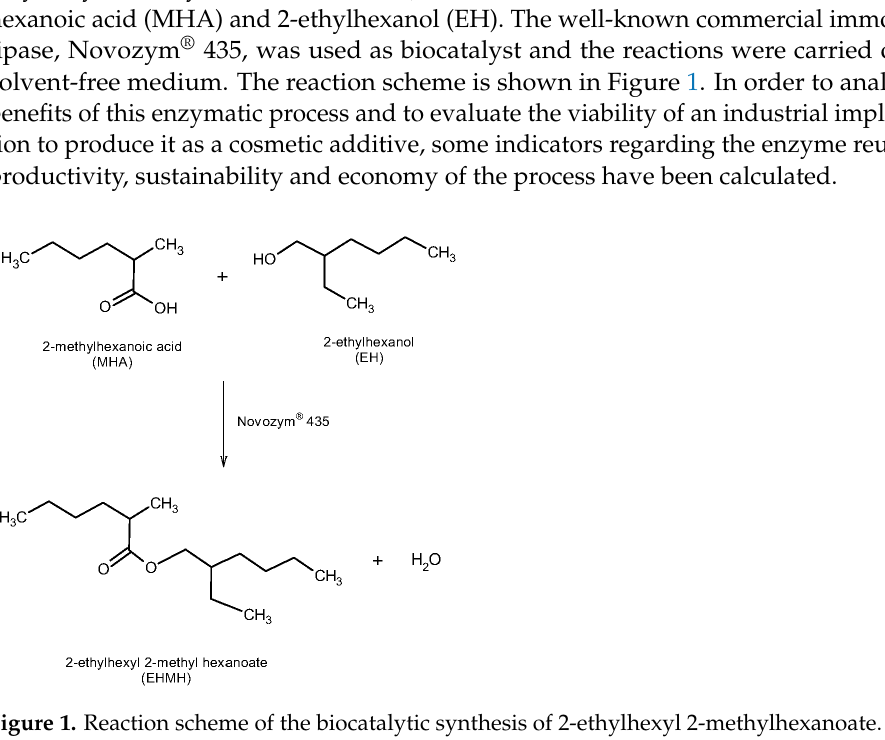
Figure 1. Reaction scheme of the biocatalytic synthesis of 2-ethylhexyl 2-methylhexanoate.